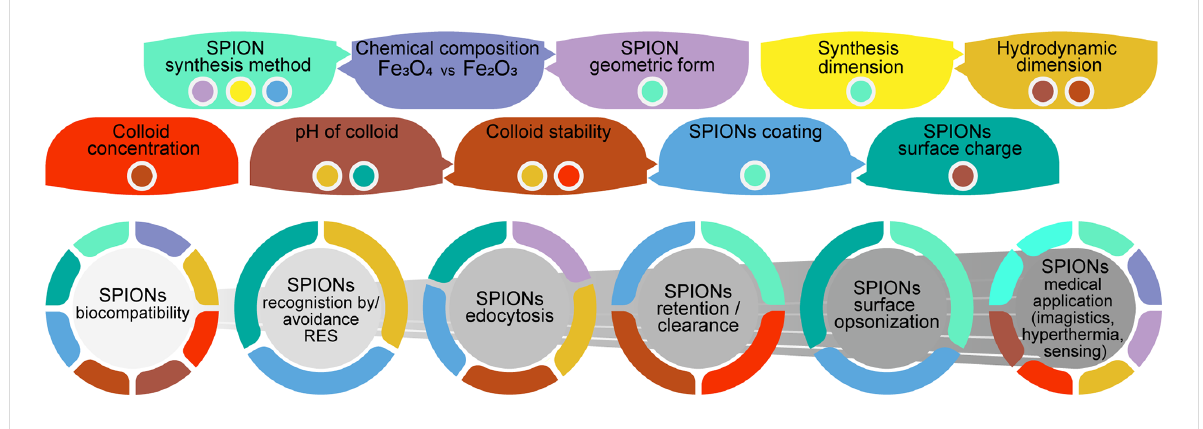
Figure 3: Schematic representation of how the physical and chemical characteristics of SPIONs influence biological response and biomedical applica- tions.